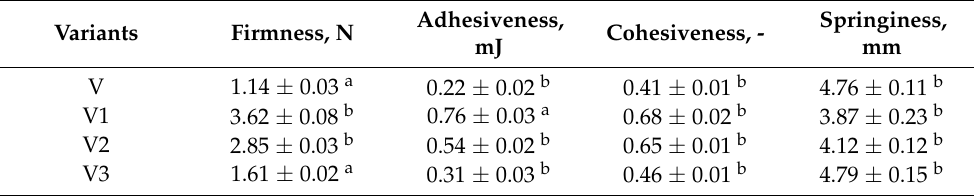
Table 3. Textural parameters of rosehip jellified products.